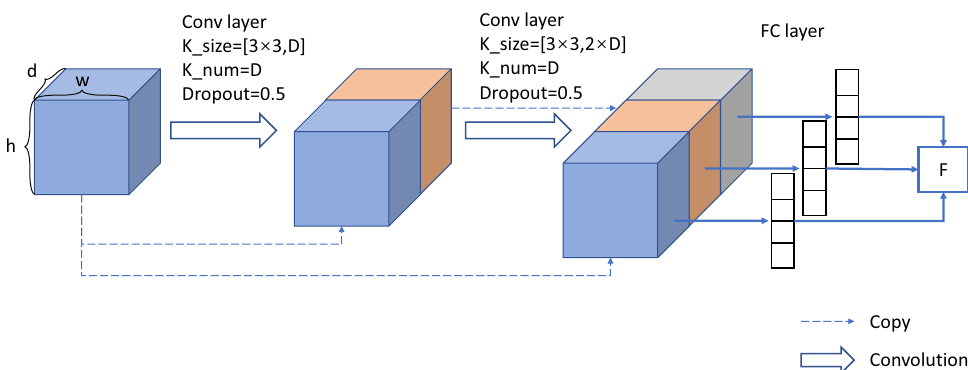
Figure 1. Overall network structure of the proposed SSKD. The figure SSL is an abbreviation for Self-Supervised Learning.